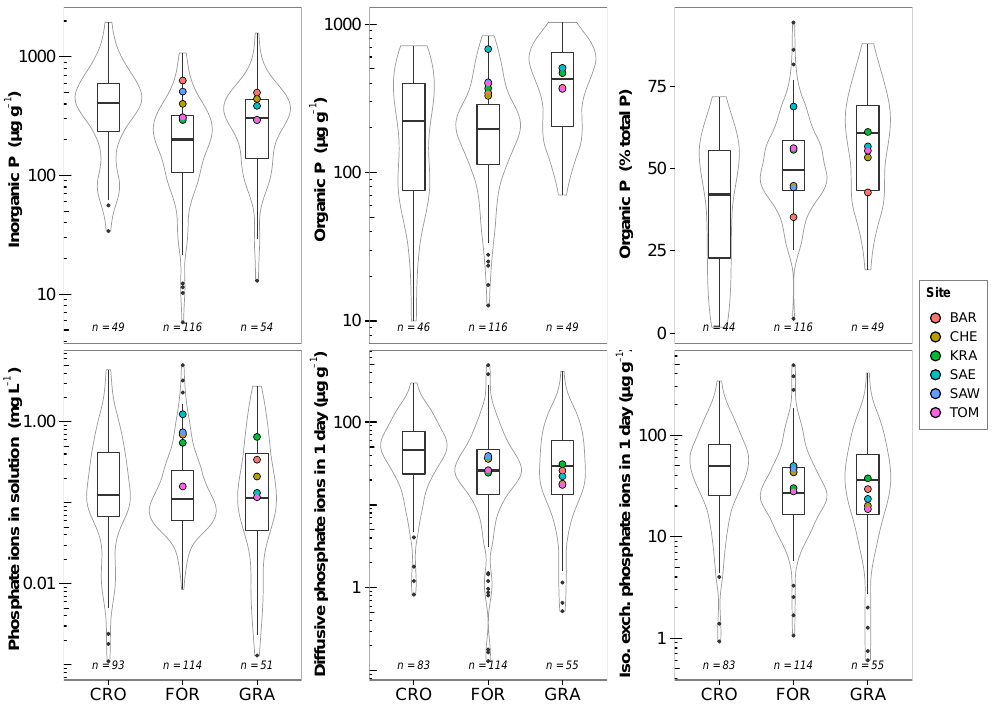
Figure 4. Comparison of the different components of the P status in topsoils (about 0 to − 20cm) of south-western Siberia (coloured dots) and different vegetation types (CRO: croplands; FOR: forests; GRA: grasslands – box and violin plots) on the global scale (croplands and grasslands) or on the country scale (forests mostly located in France, along broad gradients of soil and geology). “Iso. exchangeable” is an abbreviation for “isotopically exchangeable”. The “ n ” provided indicates the number of individual points used to build the box and the violin